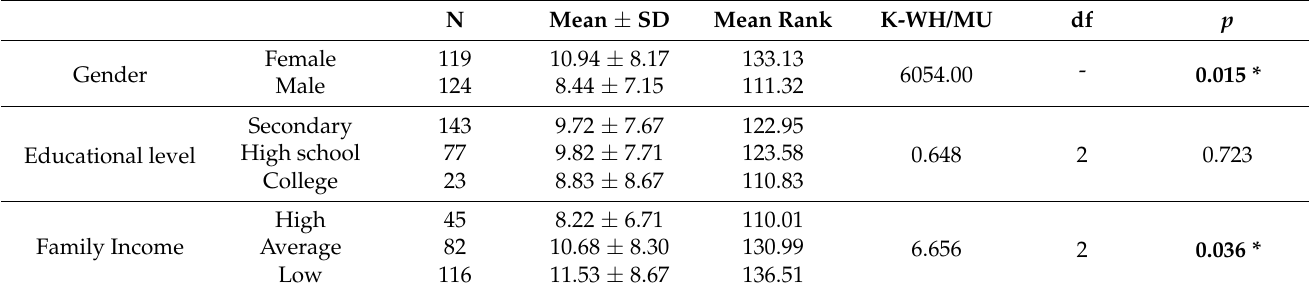
Table 3. Comparison of mean OHIP-14 score across demographic